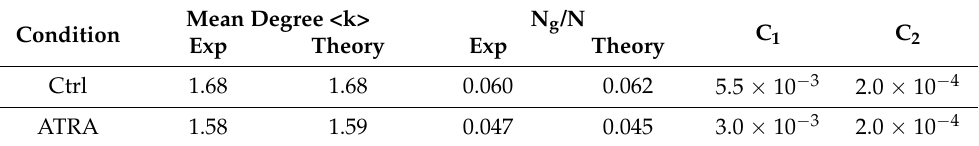
Table 1. Comparison of microscopic parameters of mitochondrial network obtained from experiments (Exp) and simulations (Theory). Mean degree (columns 2 and 3) and Ng/N (columns 4 and 5) from experiment and theory. Columns 6 and 7 list the values of C1 (tip-to-tip fusion/fission ratio) and C2 (tip-to-side fusion/fission ratio) obtained by fitting the model to the data. Notice that C1 decreased by 83% in ATRA-treated cells compared to control.